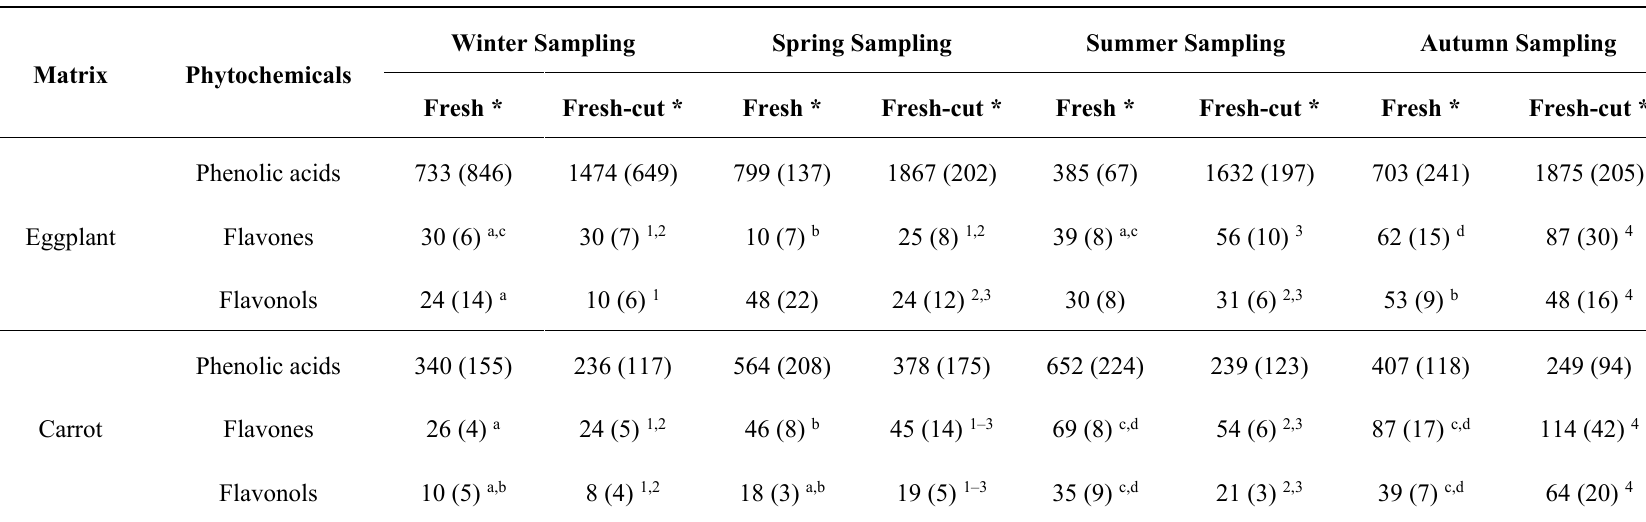
Table 2. Phytochemical content (expressed as mg/kg, dry weight (DW)) in fresh and fresh-cut in carrot and eggplant in different seasons. Matrix